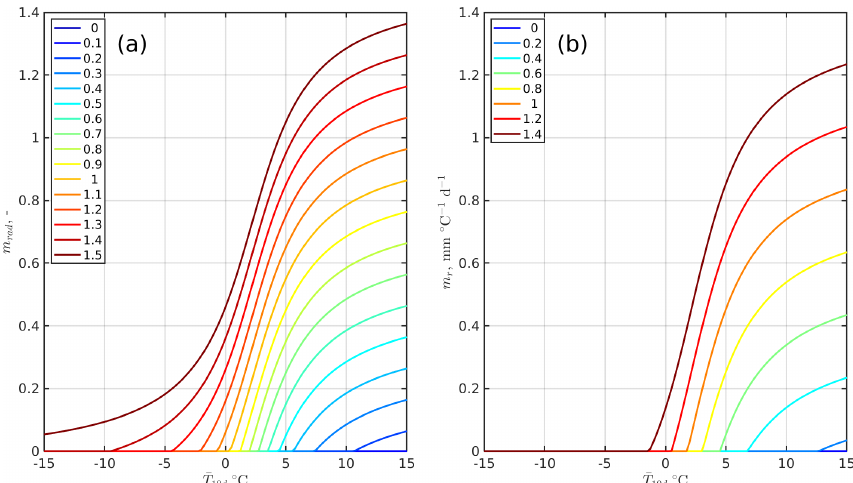
Figure 2. Values of the modulating parameter converting shortwave radiation into actual melt ( m rad , panel a ) and the degree-day melt parameter ( m r , panel b ) as a function of mean air temperature over the previous 10d ( T 10d ) and various values of two tuning parameters ( m (cid:48) and m (cid:48) r ; see figure legends for rad